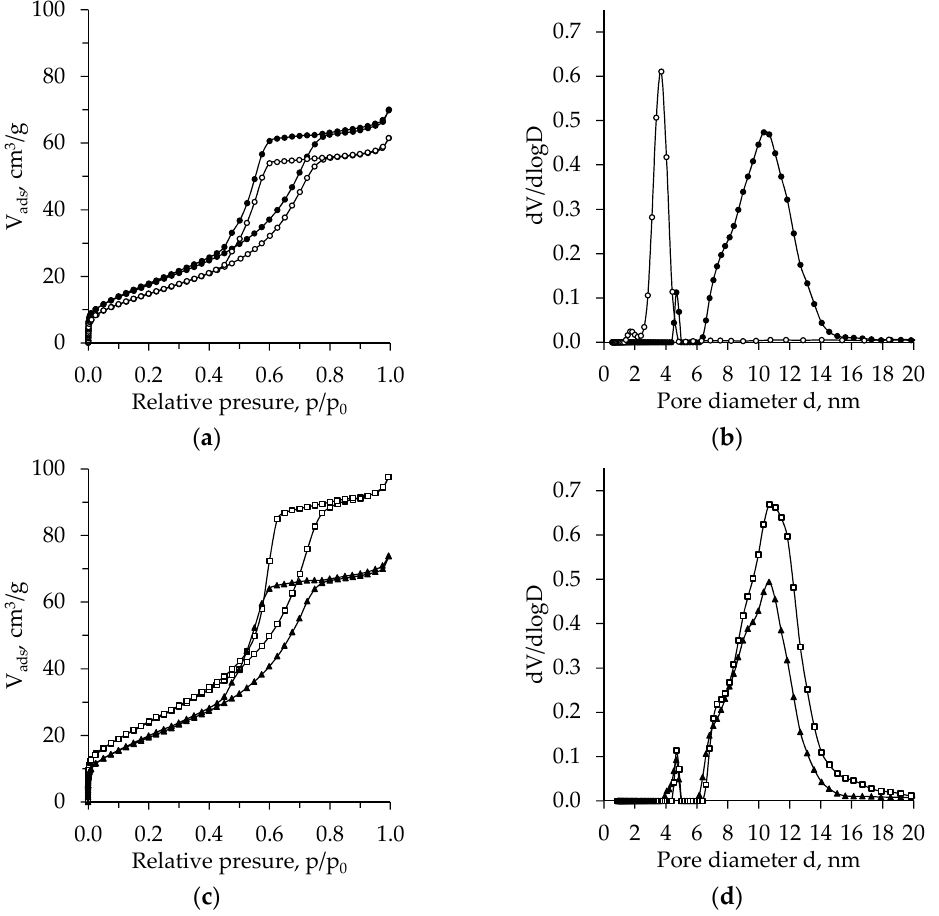
Figure 9. The BET adsorption–desorption isotherms ( a , c ) and pore size distribution ( b , d ) of calcinated TiO 2 aerogel vs. precursor (TBOT ( a , b ), TIP ( c , d ) and aging ( , ▲ –unaged, , –aged).